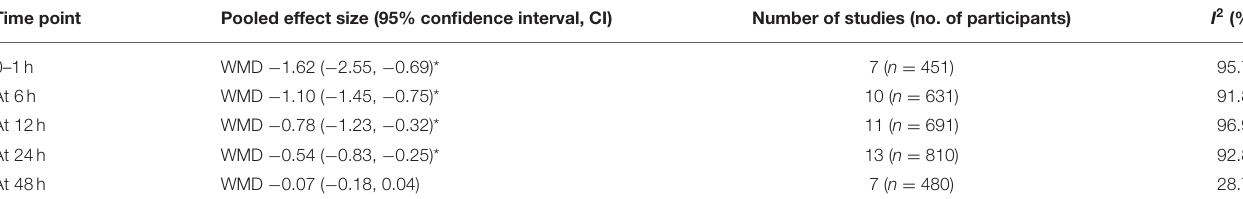
TABLE 3 | Summary result of the postoperative pain scores at rest, comparing subjects with erector spinae plane block to those with placebo or no block.